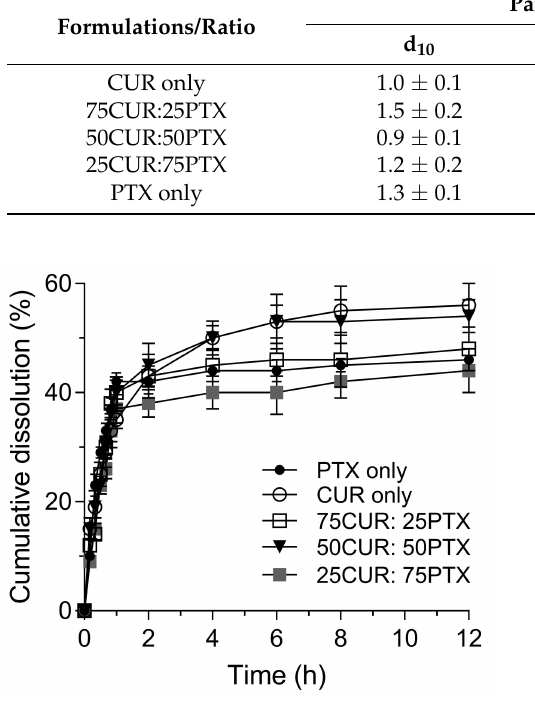
Figure 2. Comparative dissolution profile of PTX, CUR and CUR/PTX combination in phosphate buffer at a pH of 7.4 containing 1% Tween